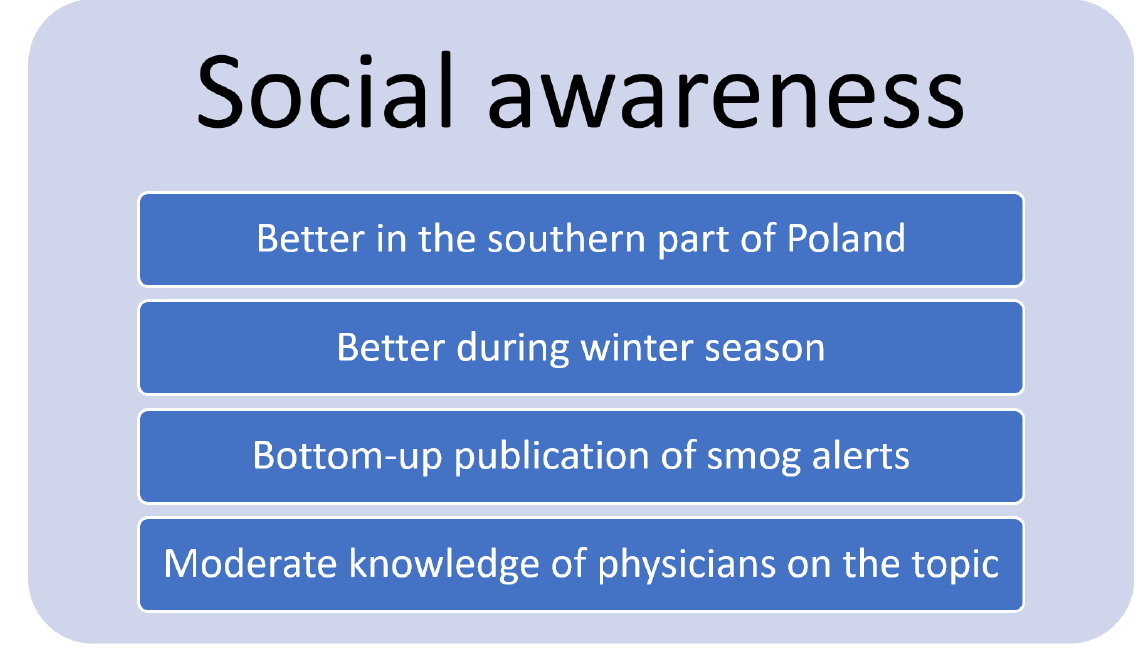
Figure 7. Characteristics of social awareness of air pollution in Poland.